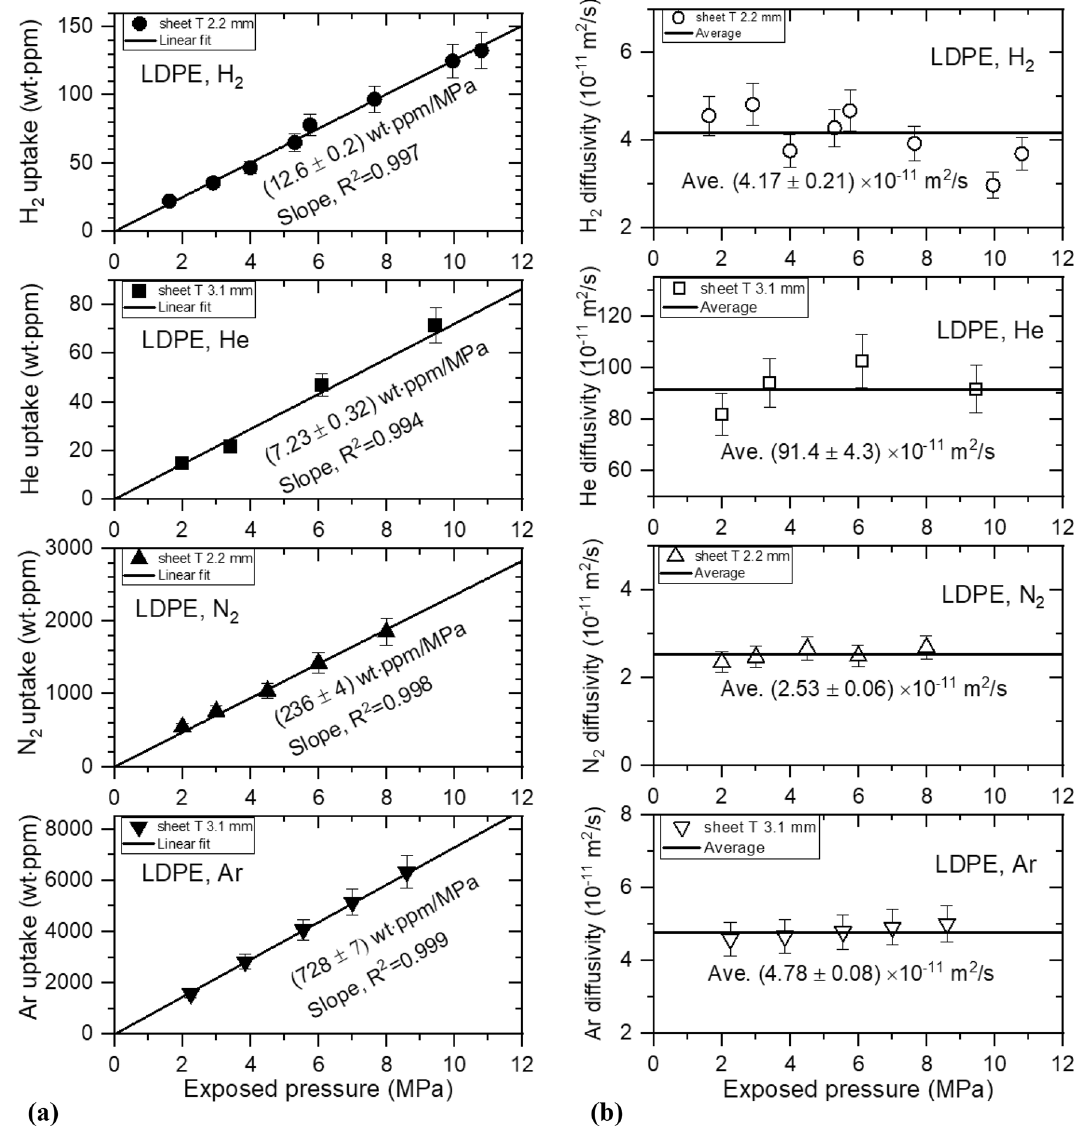
Figure 8. ( a ) Gas uptake ( C ) and ( b ) diffusivity ( D ) versus exposed pressure for four gases in LDPE sheets ∞ with different thicknesses. T indicates the thickness of the LDPE